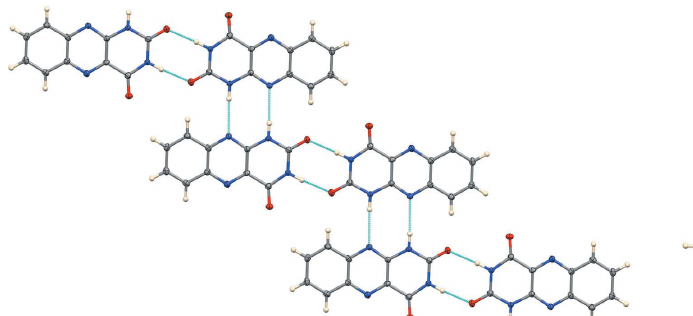
Figure 2 The hydrogen-bonded chain.